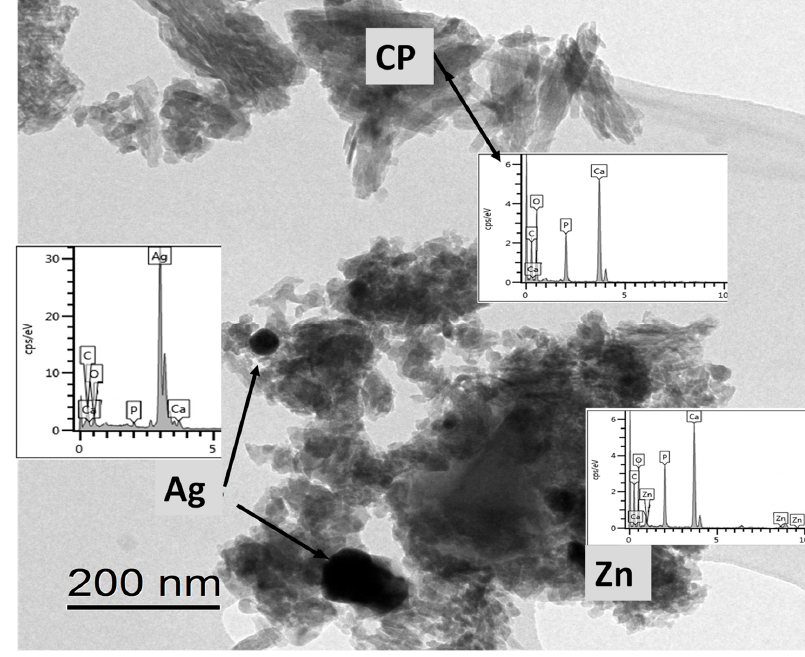
Figure 4. TEM image and EDX elemental analysis of silver and zinc substituted CP